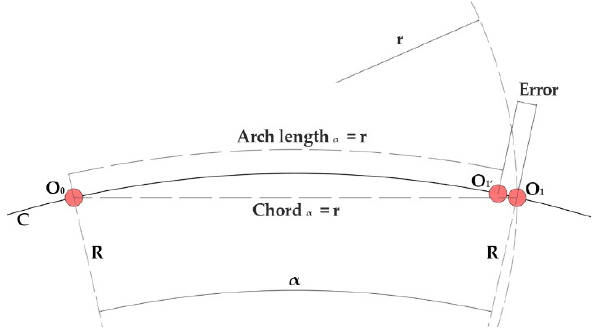
Figure 8. Compass Method accuracy error.